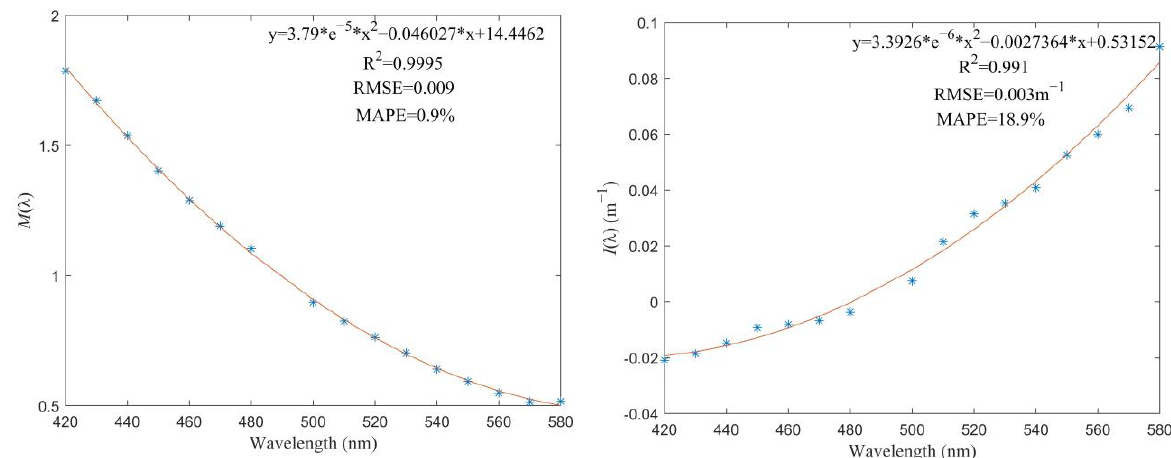
Figure 10. Quadratic regression results between the various wavelengths and the linear regression